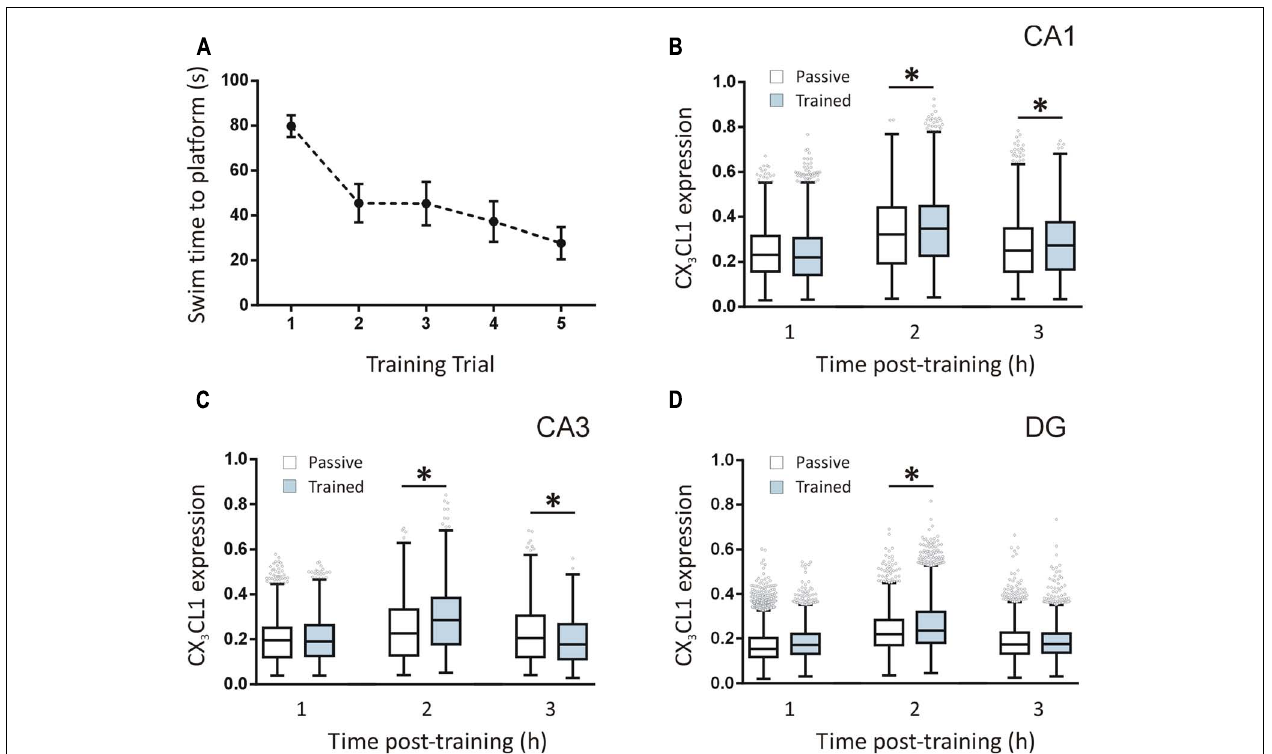
FIGURE 2 |Temporal changes in CX 3 CL1 expression in the rat hippocampus post-spatial learning measured by immunofluorescence. (A) Graph shows the average latency-to-platform times for rats trained in a single session (five trials) of the water maze task ( n = 12). (B–D) Box plots represent the distributions of fluorescence intensity values for CX 3 CL1 protein expression in CA1, CA3, and DG cells at 1, 2 and 3 h post-water maze training, compared to passive control animals. Changes